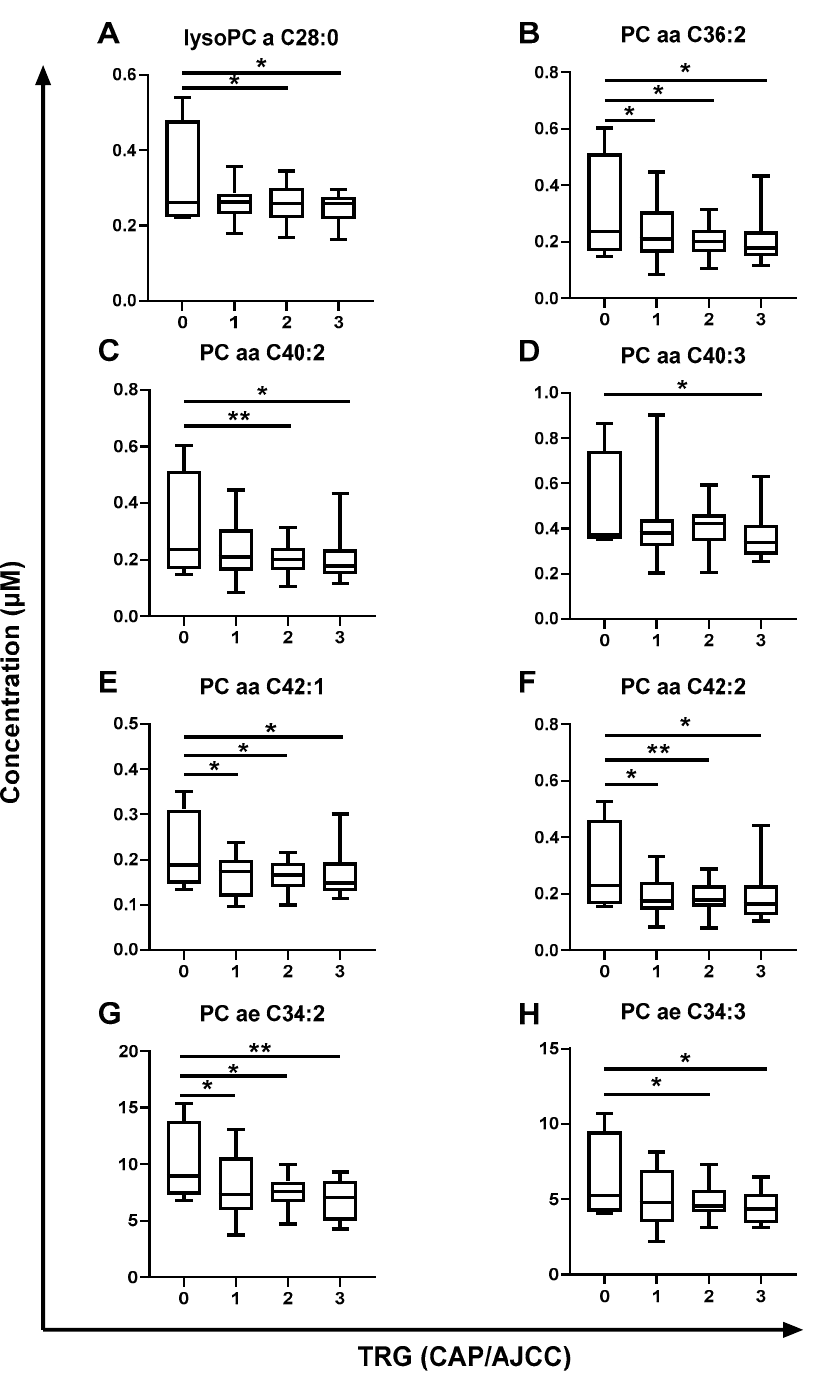
Figure 6. Pre-treatment serum metabolite levels are significantly altered across TRG in rectal cancer patients. Metabolite levels in pre-treatment sera from rectal adenocarcinoma patients ( n = 52) were assessed by liquid chromatography mass spectrometry (LC-MS) and correlated with subsequent pathological response to neoCRT. ( A ) lysoPC a C28:0, ( B ) PC aa C36:2, ( C ) PC aa C40:2, ( D ) PC aa C40:3, ( E ) PC aa C42:1, ( F ) PC aa C42:2, ( G ) PC ae C34:2 and ( H ) PC ae C34:3 levels were significantly decreased with increasing TRG and worse therapeutic response. TRG 0, n = 4; TRG 1, n = 14; TRG 2, n = 22; TRG 3, n = 12. Data are presented as medians ± minima/maxima. Statistical analysis was performed by post hoc unpaired GLM analysis. * p < 0.05, ** p < 0.01.